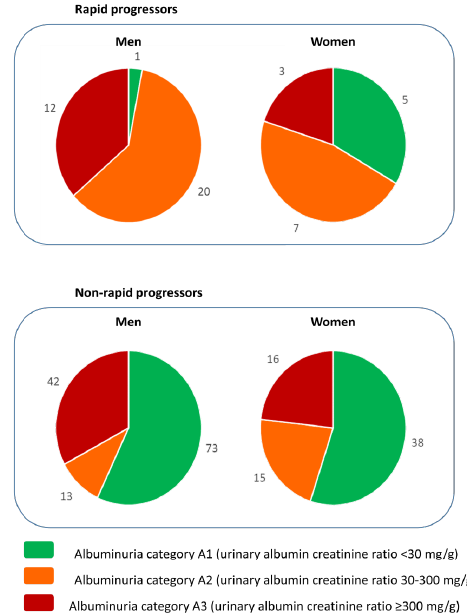
Figure 1. Baseline UACR A category and rapid progression according to sex. The number of patients in each albuminuria A category shown separately for men and for women among those that had a rapid loss of GFR (defined as loss of eGFR >5 mL/min/1.73 m 2 /year according to KDIGO 2012 [11]) and those without a rapid loss of eGFR. Albuminuria A category defined as per KDIGO 2012 [11]. Note the presence of more women than men with rapid progression in the A1 category representing the physiological albuminuria values. J. Clin. Med. 2020 , 9 , x FOR PEER REVIEW